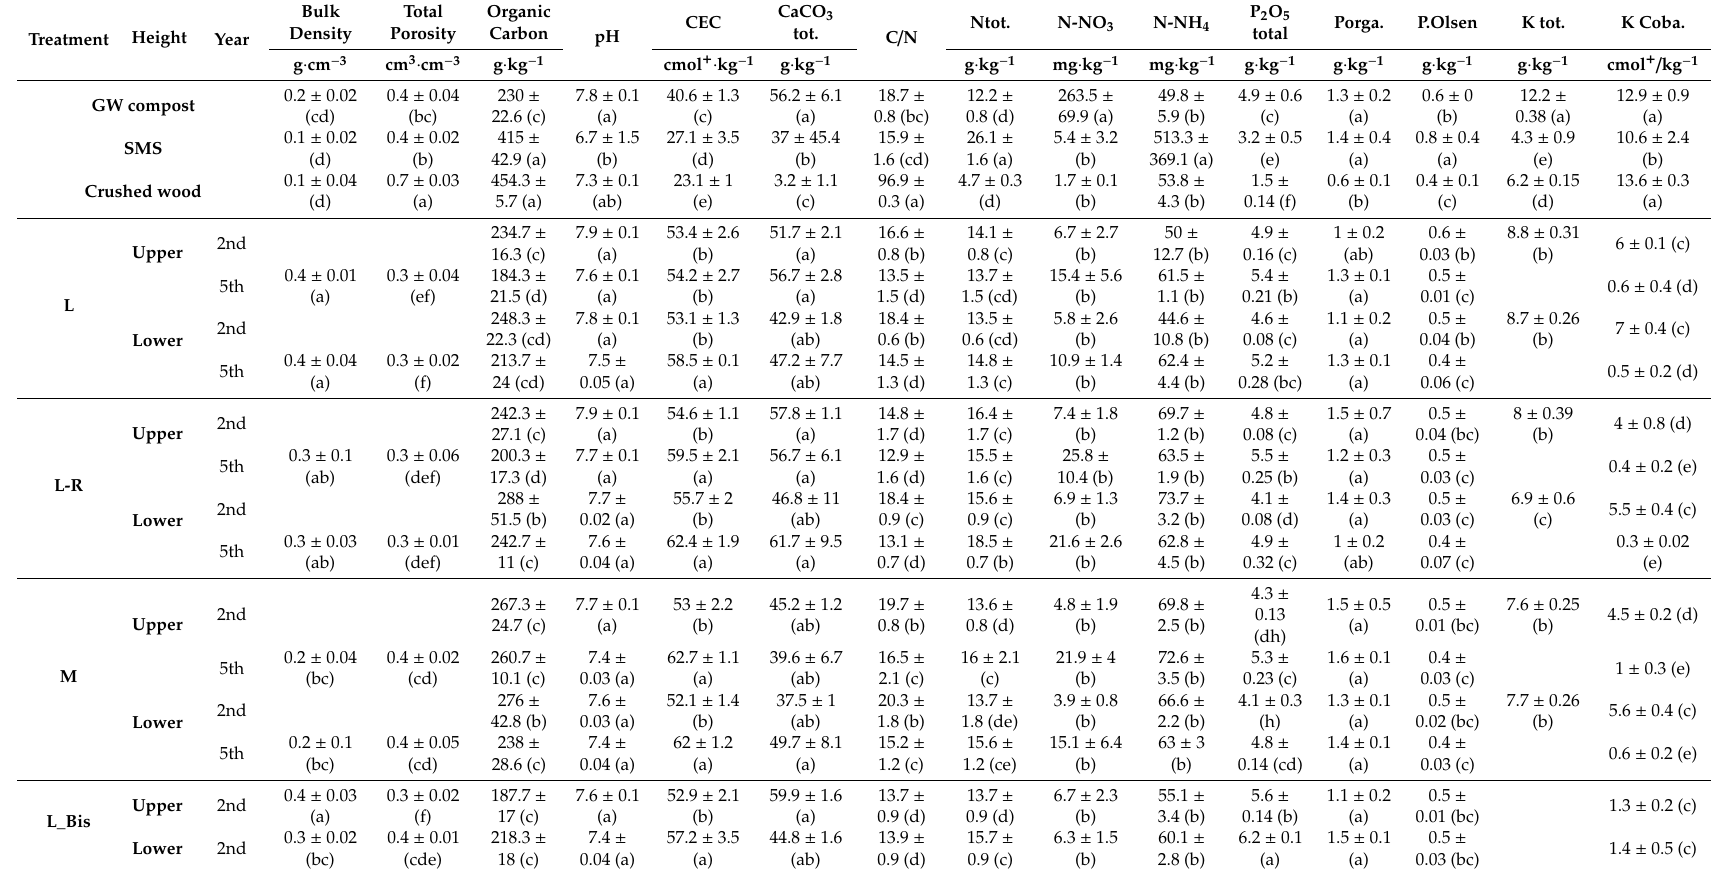
Table 4. Physical and chemical soil characteristics over time. All results are expressed per kg of dry matter. Statistical test allow comparison between parental material (green waste compost; spent co ff ee grounds and crushed wood) and a single treatment. Treatment are not here comparable. (a), (b), (c), ... : refers to statistical analysis. Per treatment, two layers without a common letter are significantly di ff erent ( p -value < 0.05). GW = green waste compost; SMS = spent mushroom